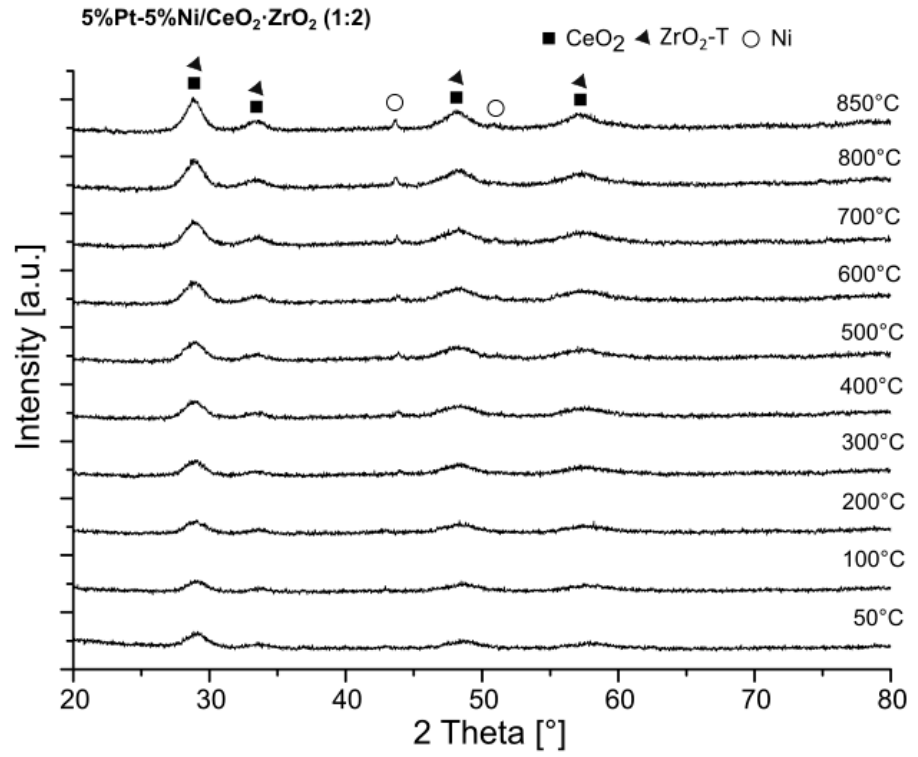
Figure 5. The X ‐ ray diffraction measurements recorded for 5%Pt ‐ 5%Ni/CeO 2 ∙ ZrO 2 (1:2) catalyst per ‐ Figure 5. The X-ray diffraction measurements recorded for 5%Pt-5%Ni/CeO 2 · ZrO 2 (1:2) catalyst formed the “in situ” reduction process. performed the “in situ” reduction